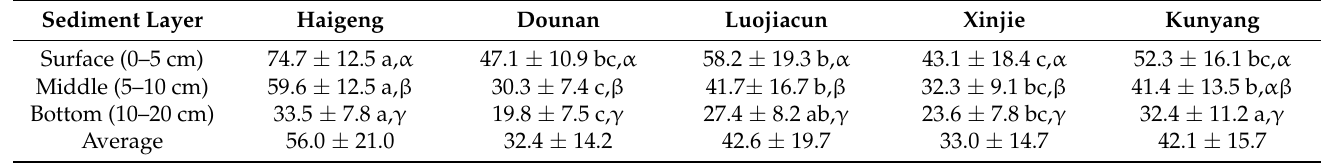
Table 3. Spatial variation in available-P in sediment of Dianchi lake (P mg kg − 1 ).